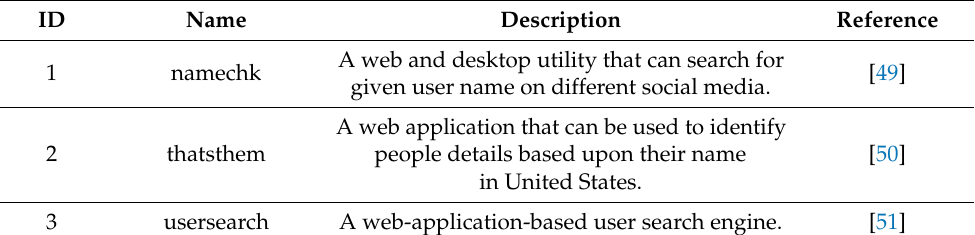
Table 9. Tools used for OSINT on usernames.